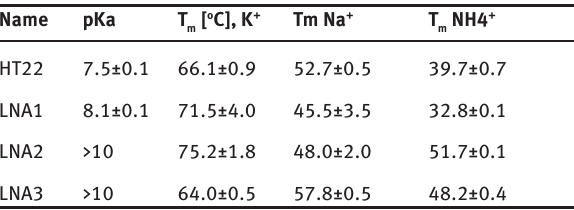
Table 4: Melting temperatures (T (pKa) for HT22 and LNA-modified oligonucleotides.